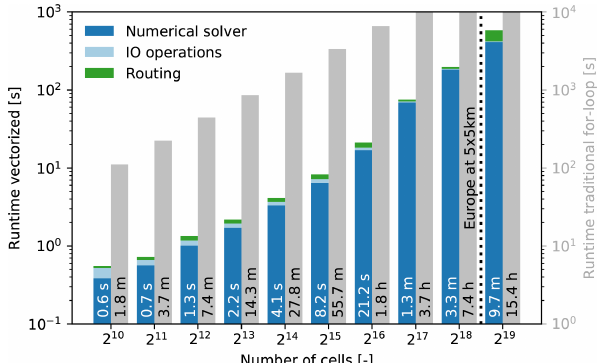
Figure 5. Runtimes for a simulation of 3 months with an hourly time step with varying number of pixels, run on a single core of a normal desktop (Intel Core i7-6700, 16GB RAM). The grey bars represent model runtimes where the numerical solver is called for each individual pixel and are keyed to the right-hand scale, making the difference in runtimes appear smaller than it really is. The dot- ted line represents the number of pixels when simulating Europe at 5 × 5km 2